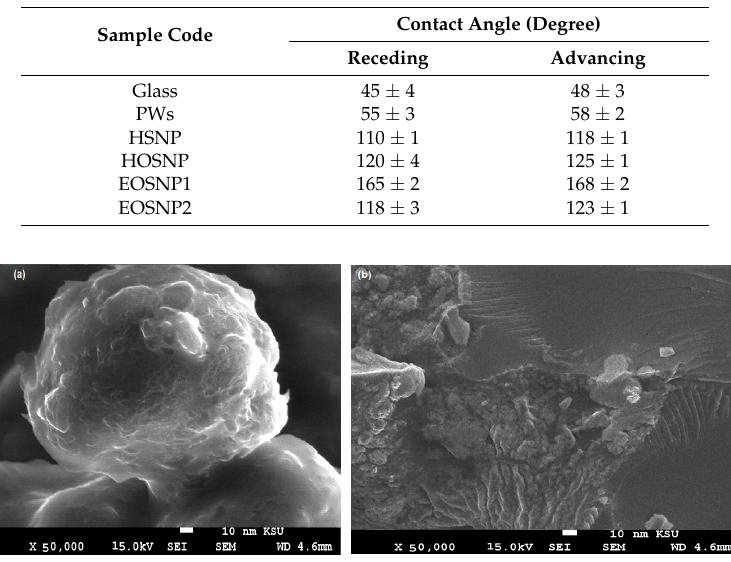
Figure 5. SEM images of ( a ) EOSNP1 on the sand surface, and ( b ) the crushed EOSNP1 film.